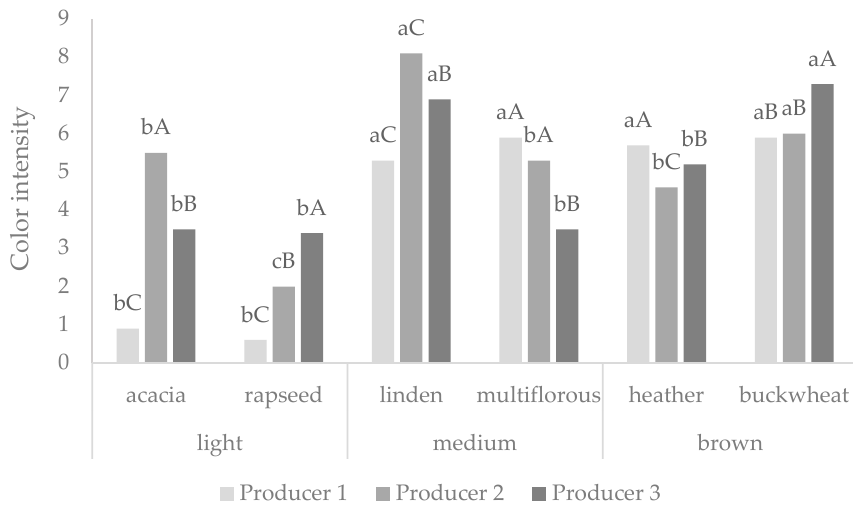
Figure 2. Color intensity measured by the sensorial panel. Values are presented as the mean ± standard deviation. a,b Values followed by different letters in the same column are significantly different ( p < 0.05), as determined by the Tukey’s multiple comparisons test. A–C Values followed by different